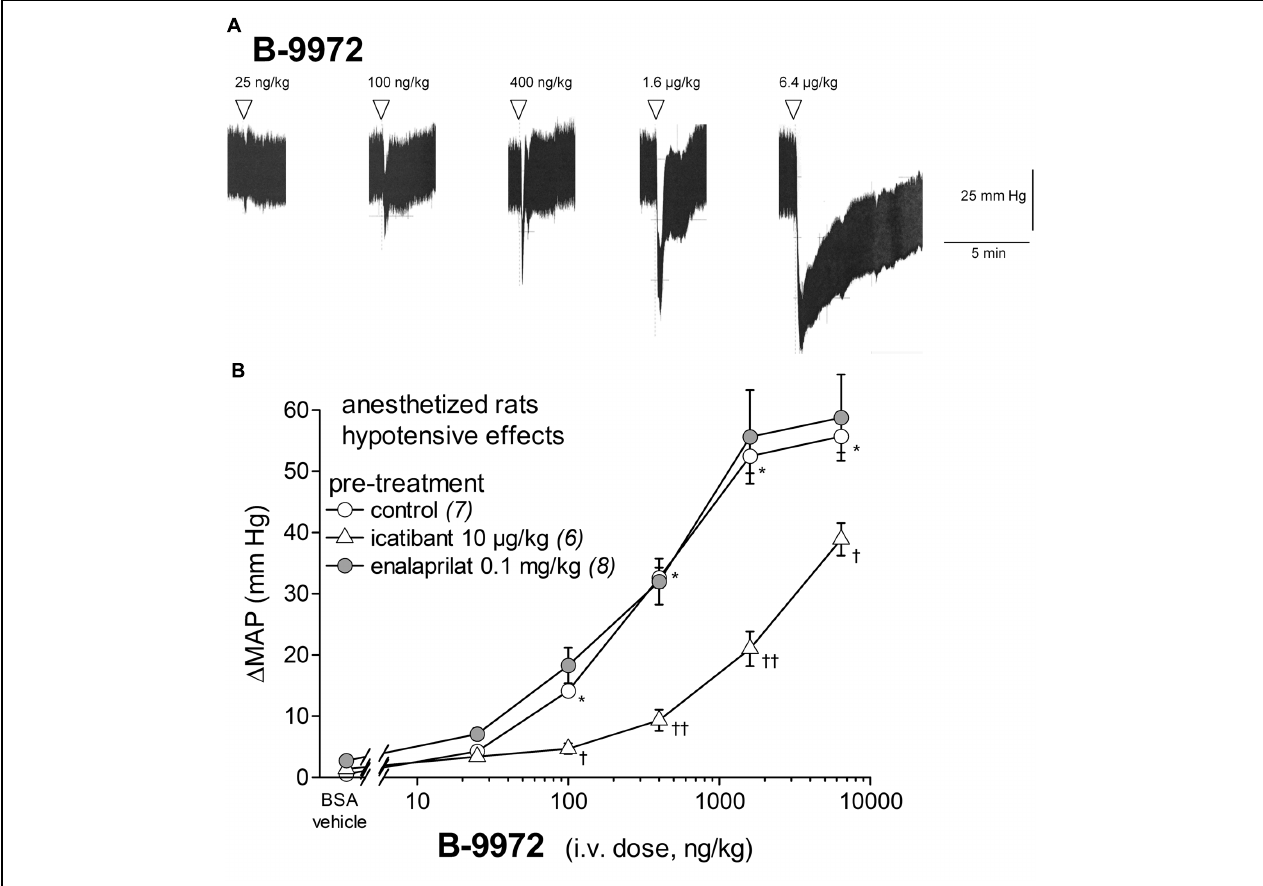
FIGURE 4 | Hypotensive responses to i.v. bolus injections of increasing doses of B-9972 in anesthetized rats. (A) Representative traces showing the dose-response effect of B-9972 on systemic blood pressure. Doses of B-9972 are in ng/kg. Abscissa: time; ordinate: arterial pressure (mm Hg). (B) Effect of i.v. pretreatment with enalaprilat (0.1 mg/kg) or icatibant (10 µ g/kg) on the maximal hypotensive response to i.v. injections of increasing doses of B-9972. The pretreatment with the peptidase inhibitors was given as bolus 15 min before starting the injections of B-9972. The number of determination in different animals is given between parentheses for control and each inhibitor. Abscissa: dose (ng/kg); ordinate: fall of (MAP; mm Hg). Values are means ± SEM shown by vertical lines. ∗ P < 0.01 control group values compared with vehicle value; † P < 0.05; †† P < 0.01 pretreated group values compared with the control group values (Dunnett’s test).